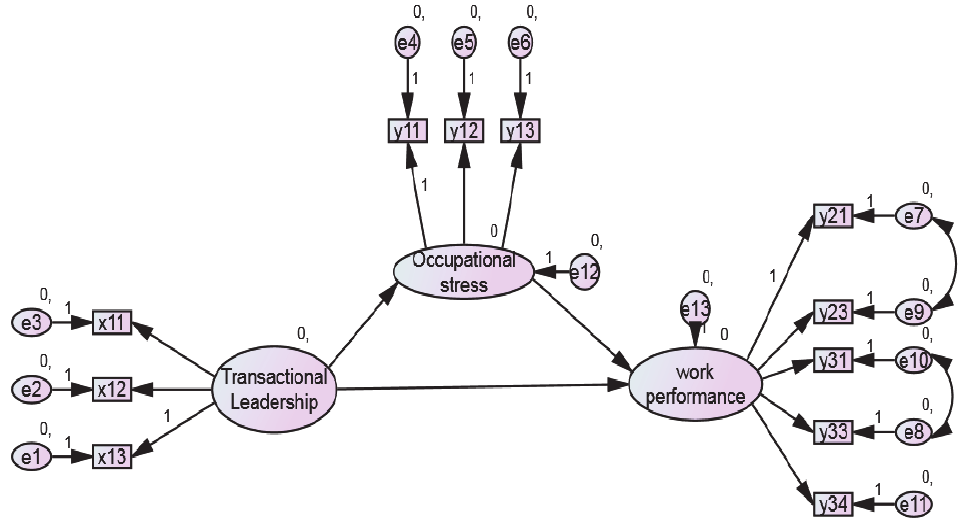
Fig. 3. Structural Model Graphic for SEM Stage